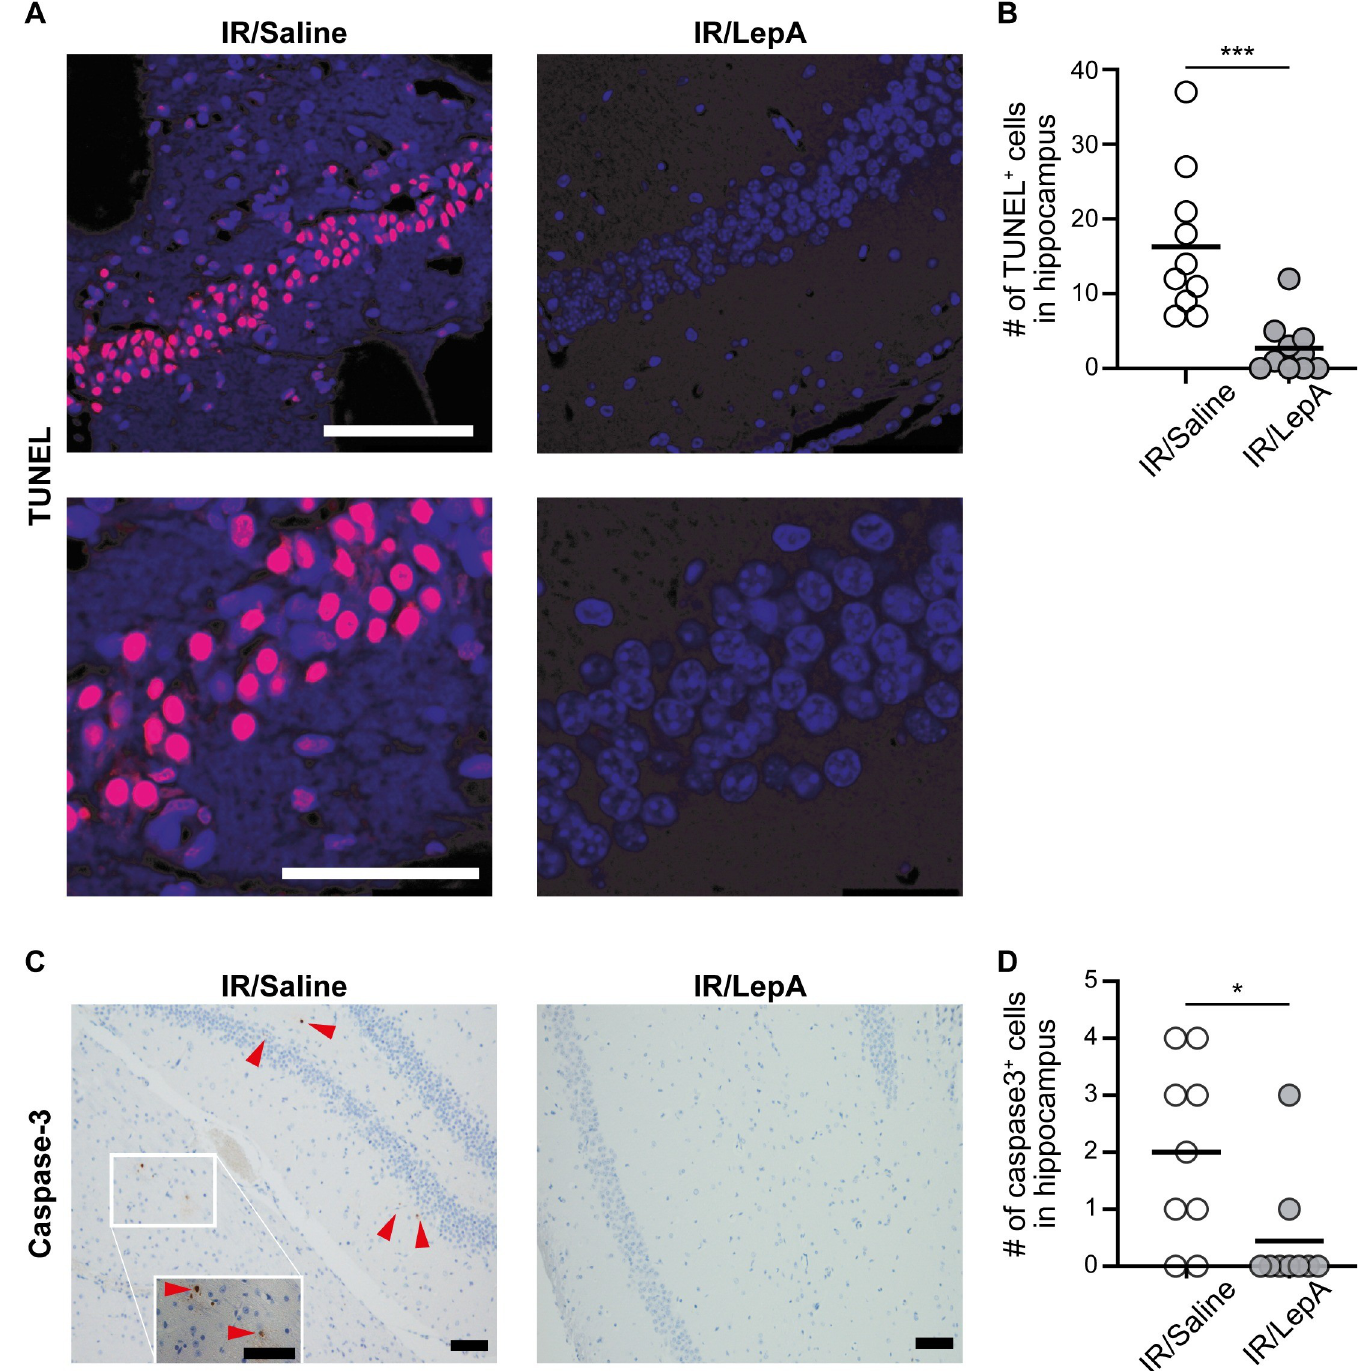
Fig 2. LepA applied IA into ipsilateral ICA at reperfusion prevents apoptosis. ( A ) Representative TUNEL analysis images indicating increased CA1 cell death in saline treated mice versus LepA treated mice. Nuclear signal (magenta) represents fragmented DNA in nucleus (Dapi; blue) of dying cell. ( B ) Less TUNEL staining was evident in following LepA treatment compared to saline (n = 10, unpaired two-tailed Mann-Whitney U = 4.5, p = 0 . 0002 ). ( C ) Representative images of caspase3 staining following ischemia and reperfusion. Caspase3 was evident in (1) CA1 region of IR/saline-injected mice (arrows), but not in (2) IR/LepA-injected counterparts. ( D ) Less caspase3 positive cells were evident in the IR/saline group compared to IR/LepA group (n = 9, unpaired two-tailed Student t-test, t (16) = 2.485, p = 0 . 0244 ). Scale bars are 100 μ m.